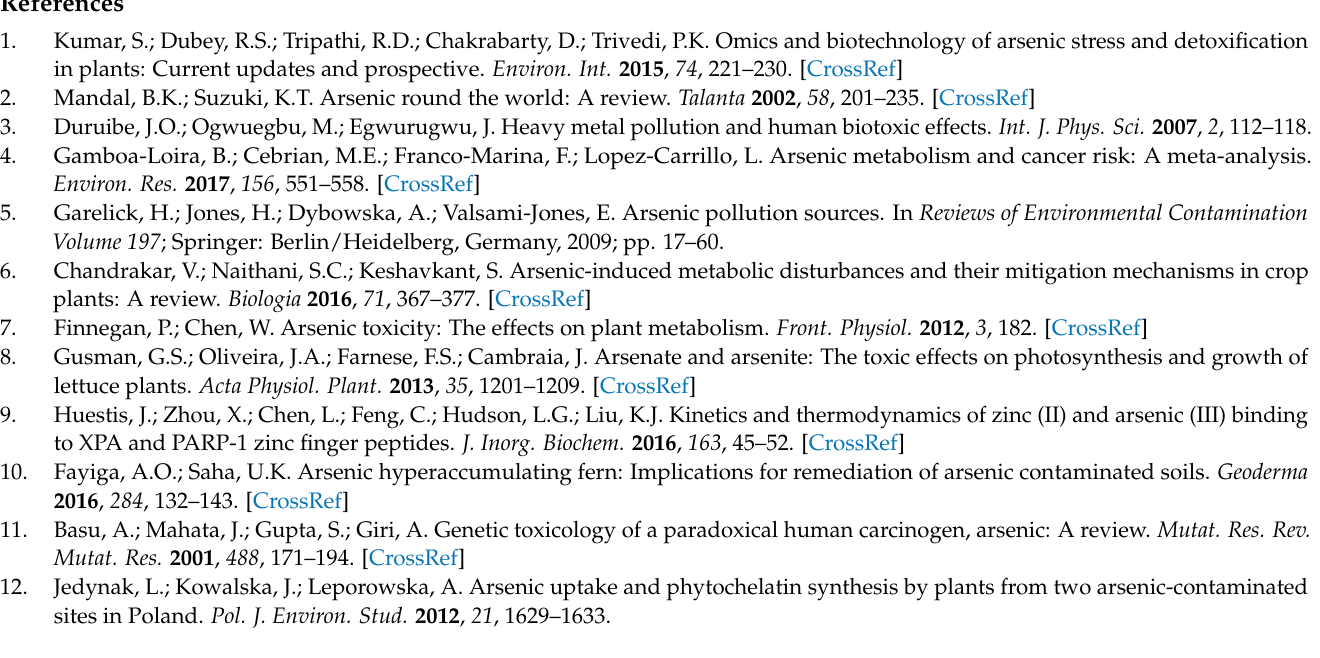
Table S3: BUSCO results: The number of single-copy conserved orthologs found in the